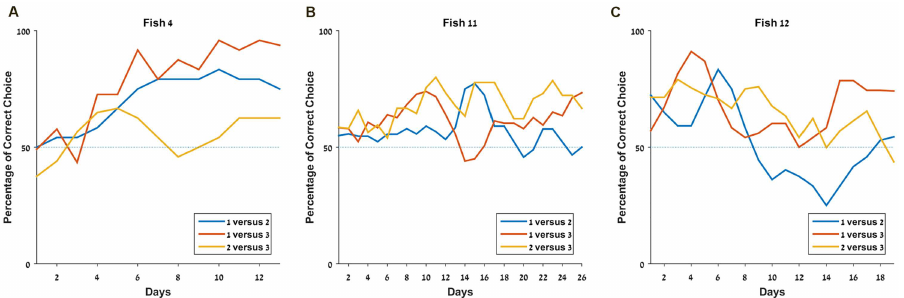
Fig 6. Some fish are able to organize shapes according to the value associated with them. A. Details of the experiment with three shapes for the pairs comparisons for Fish 4. B. Details of the experimentwith three shapes for the pairs comparisons for fish 11. C. Details of the experimentwith three shapes for the pairs comparisons for fish 12.